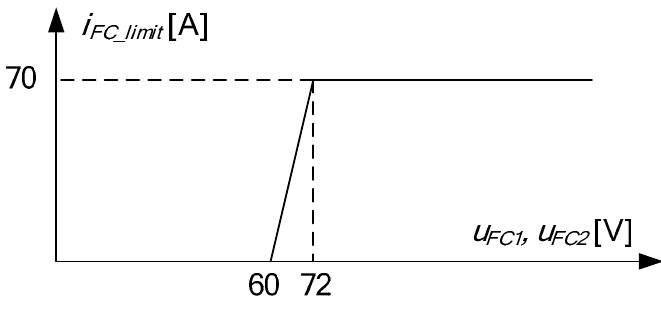
Figure 9. Fuel cell under-voltage protection function i FC_limit = f(u FC ) .